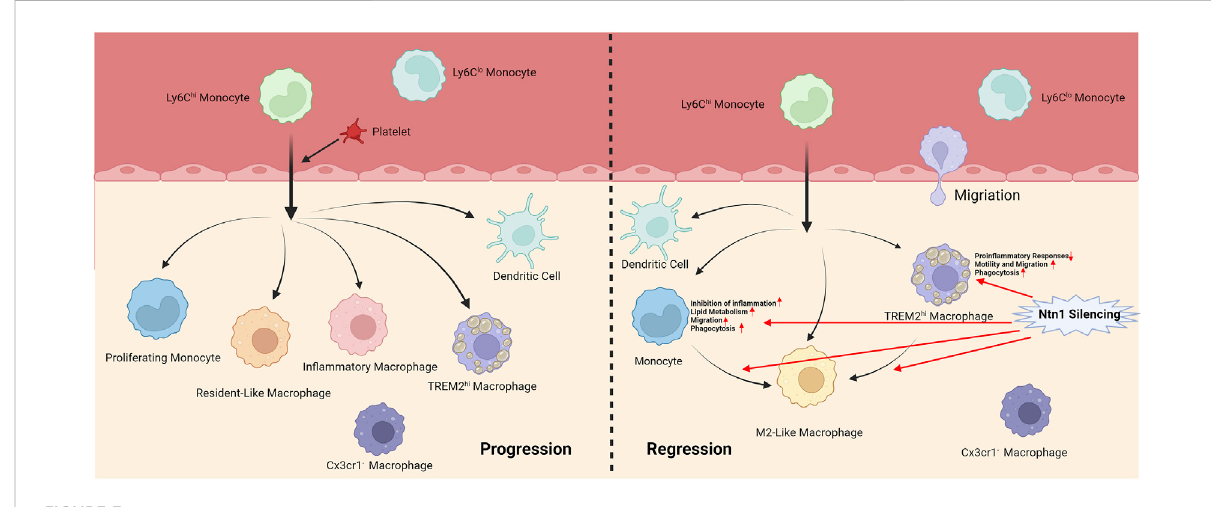
FIGURE 3 Different phenotypes of monocytes and macrophages during progression and regression of